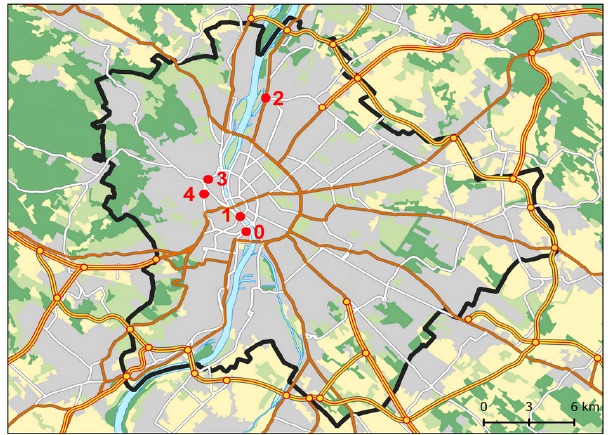
Figure 1. Location of the measurement sites in Budapest. 0: BpART Laboratory, 1: Szabadság Bridge, 2: Váci Road, 3: Széna Square and 4: Alkotás Road. The border of the city (in black colour), the Danube River and the major routes are also